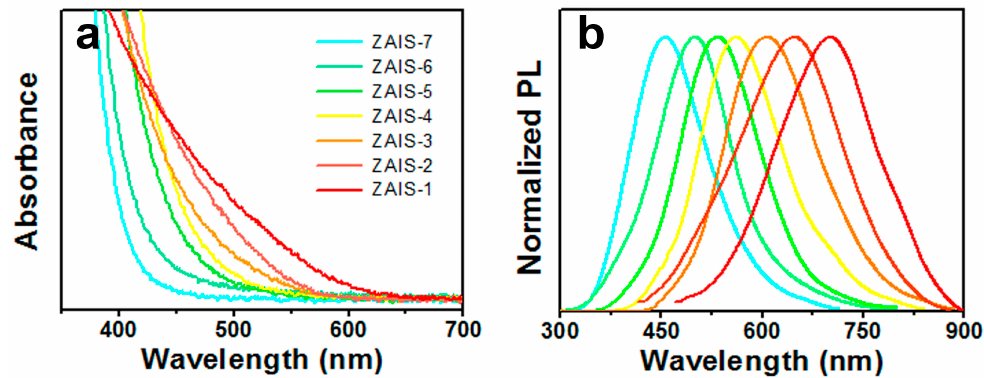
Figure 2. ( a ) UV-vis absorption spectra and ( b ) PL spectra of the ZAIS NCs (ZAIS-1 to ZAIS-7) in chloroform. Table 1. Chemical compositions of the ZAIS NCs (ZAIS-1 to ZAIS-7) determined by inductively